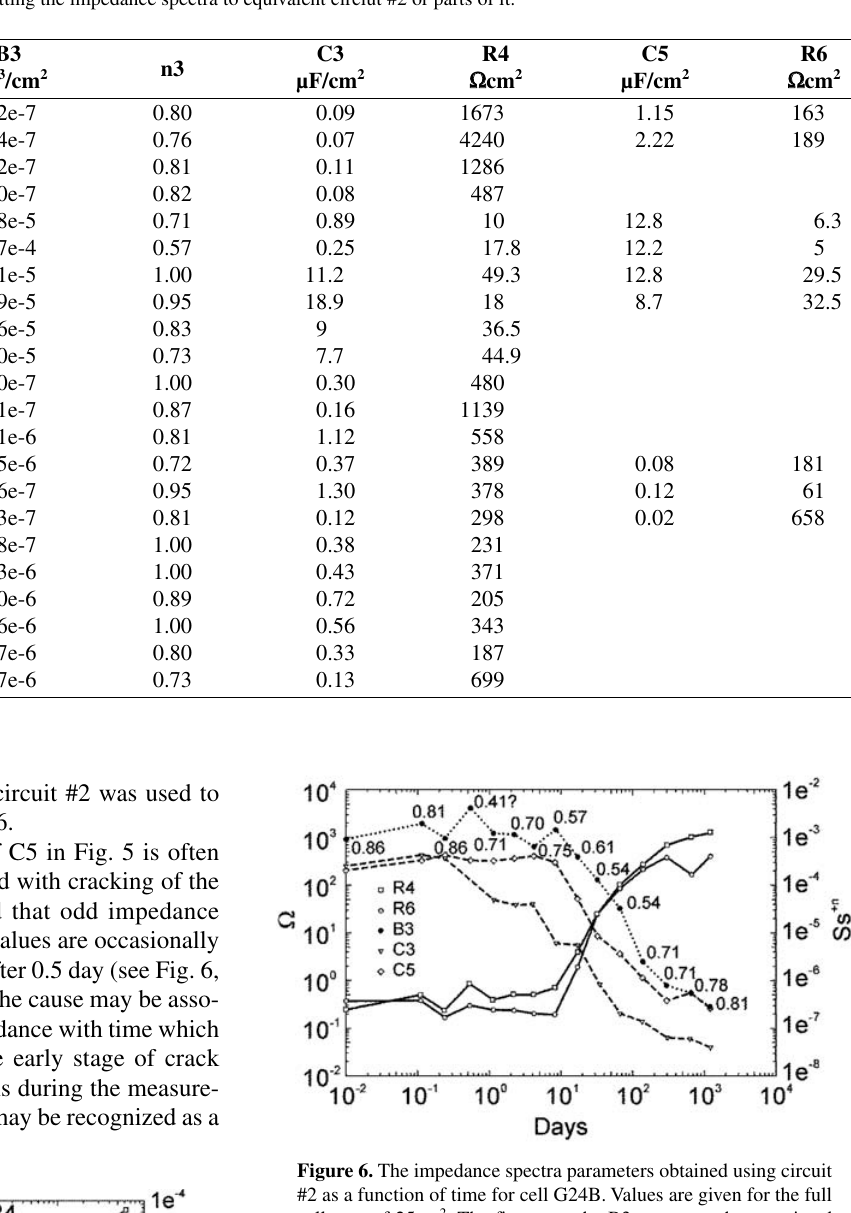
discontinuity in the spectrum whereas the early stages of crack healing are very difficult to identify with certainty and only question marks can be put